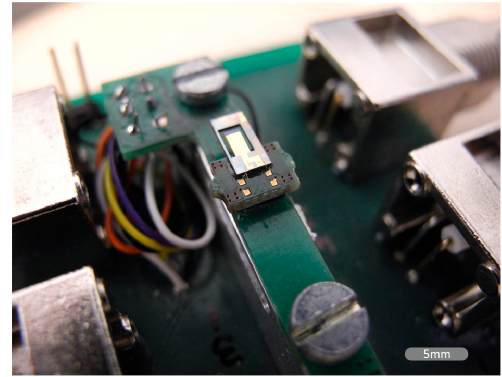
Figure 2. Photo of the custom-built shaker mounted with a bonded MEMS cantilever. The complete set-up is placed in a vacuum-controlled chamber having an optical access for the